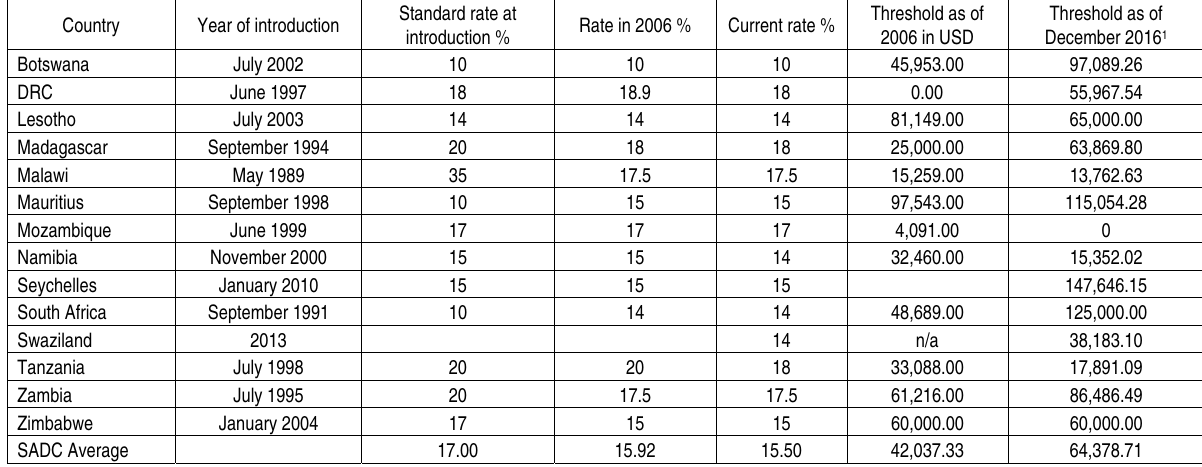
Table 1. VAT years of introduction, rates and thresholds in SADC countries